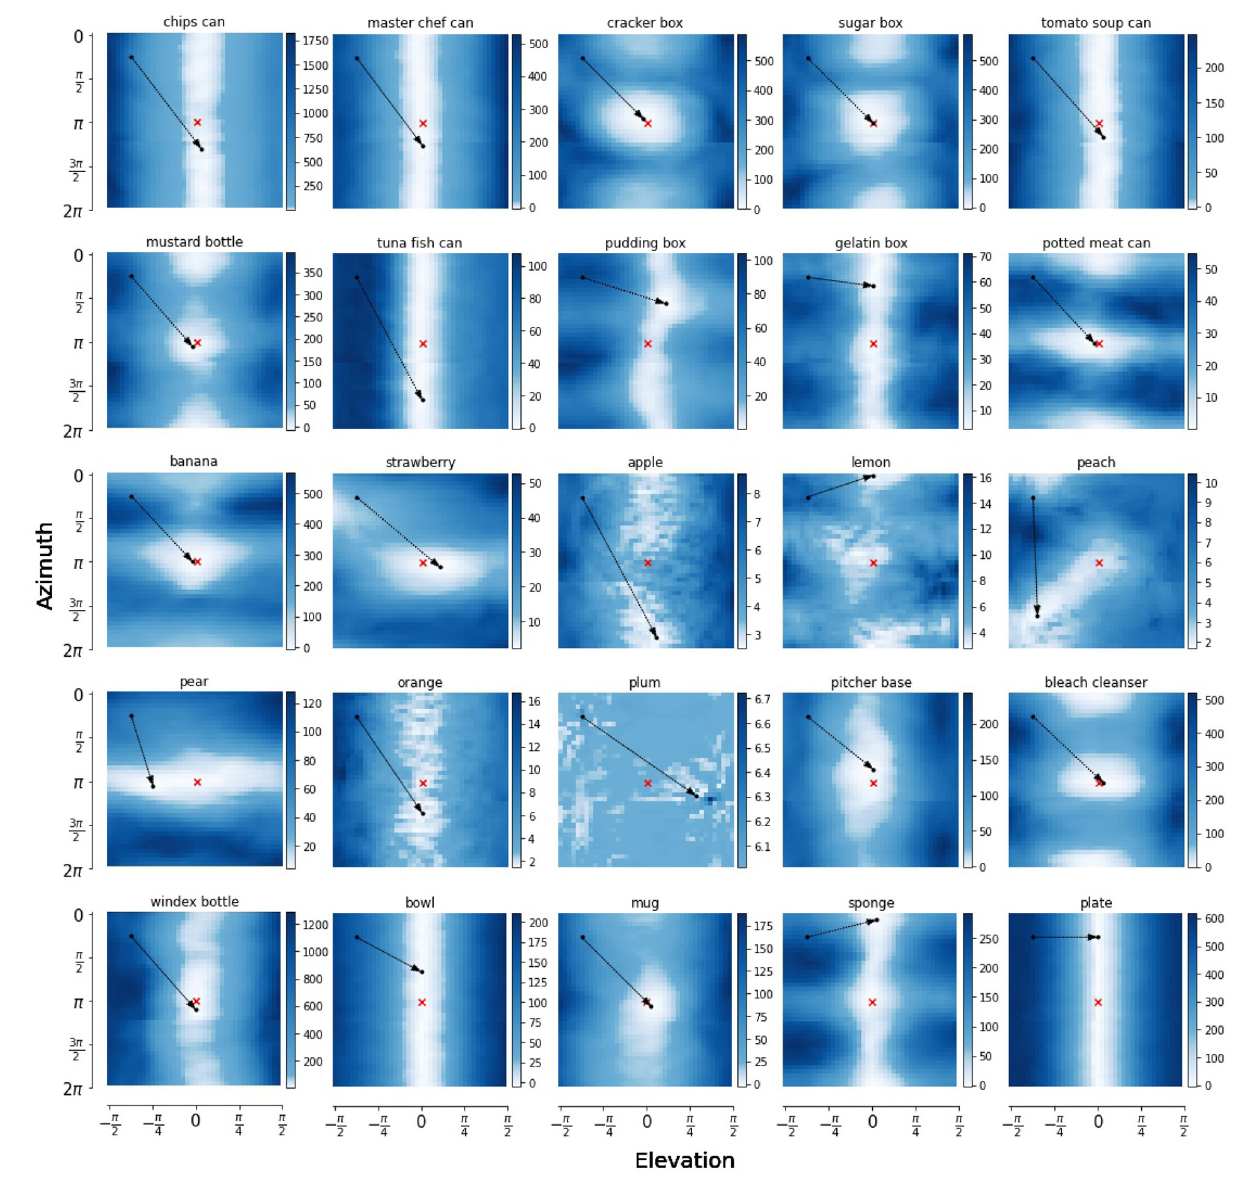
FIGURE 8 | Heatmaps of the expected free energy G for reaching a target observation, marked by the red x. The pose parameters radius and angle θ around the z-axis of the camera are kept in a fixed position, while varying the azimuth and elevation angle over their full range in 40 linearly spaced points in each dimension. The initial point and the point with lowest expected free energy G are marked by black dots. The arrow head points at the point with lowest free energy, starting at the pose of initial